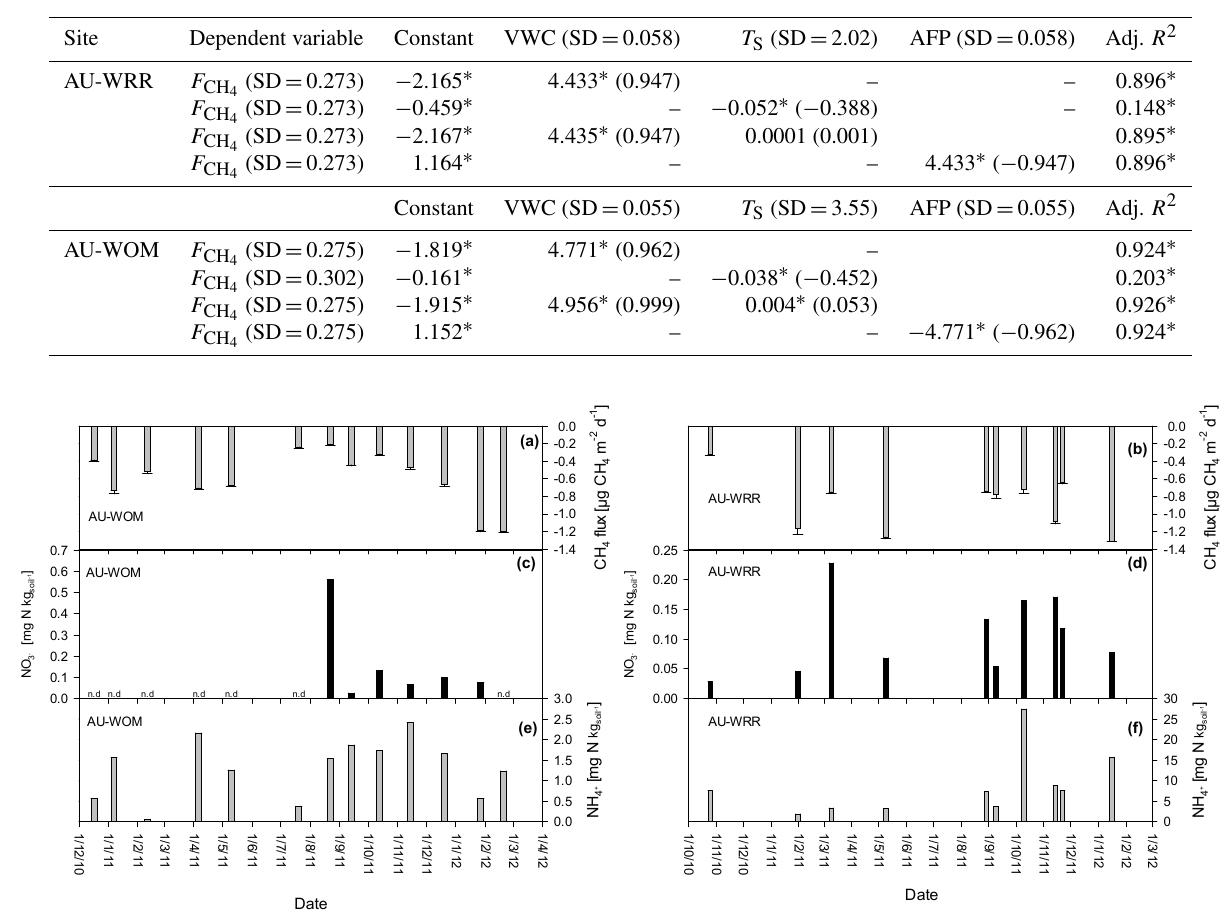
Figure 5. Dynamics in soil CH 4 flux (a, b) soil nitrate levels (c, d) and soil ammonium levels (e, f) at a mixed Eucalyptus obliqua forest stand, Wombat State Forest, Victoria (AU-WOM) and a mixed E. obliqua and E. regnans forest stand, Warra LTER, Tasmania (AU-WRR), Australia; n.d means not detectable. Results of the linear regression analysis between CH 4 and NH + / CH 4 (Adj. R 2 = 0 . 06, p = 0 . 21) NH + They were AU-WOM: NO − 3 R 2 = − 0 . 11, p = 0 . 80) NH + / CH 4 (Adj. R 2 = − 0 . 11, p = 0 . 4